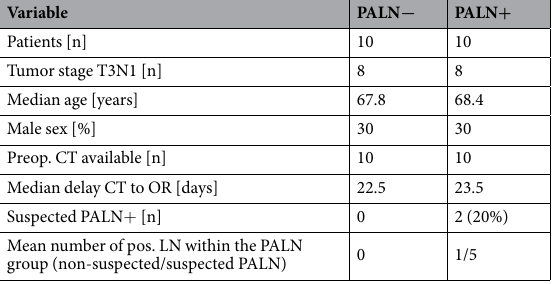
Table 4. Radiologic prediction of para-aortic lymph node status. Abbreviations: CT, computed-tomography; LN, lymph nodes; OR, operation; PALN, para-aortic lymph nodes; preop,